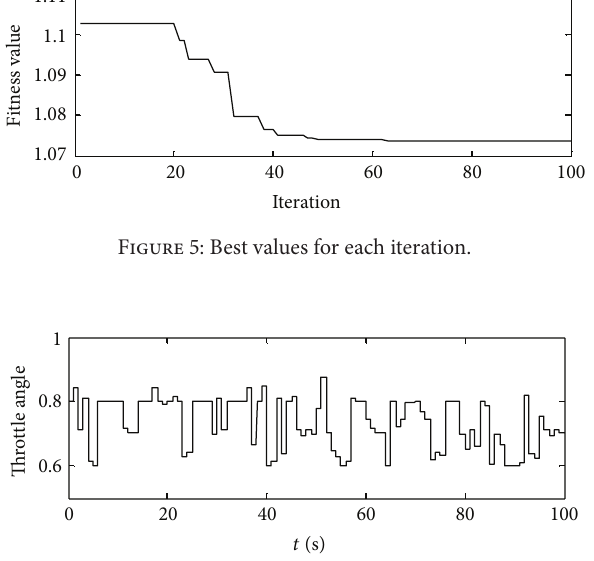
Figure 6: A group of optimized throttle angle demands for the engine.